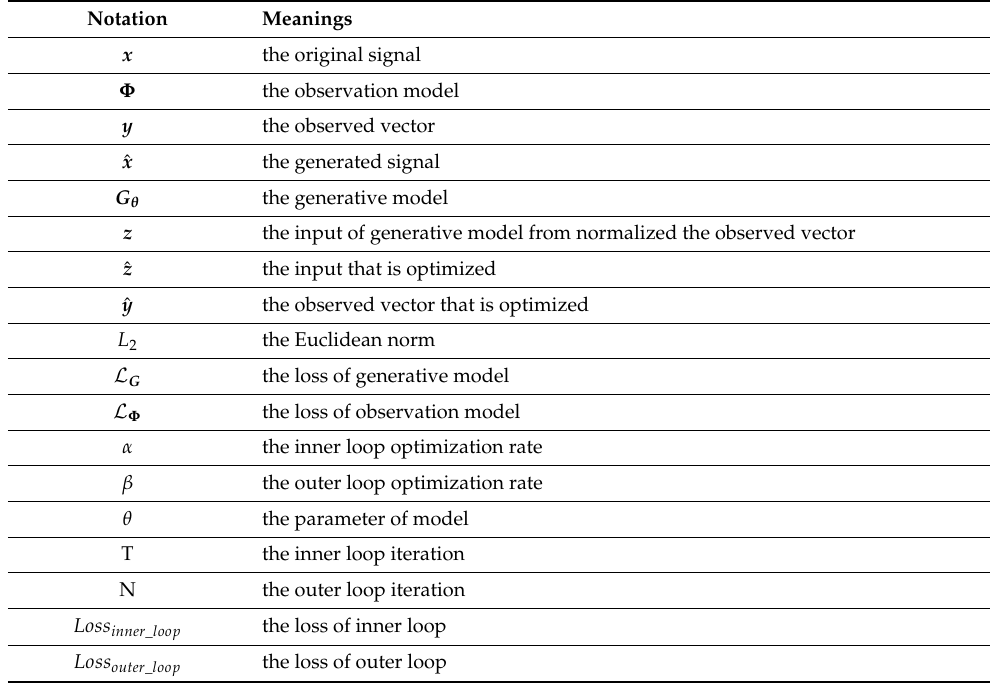
Table 1. Notations and their